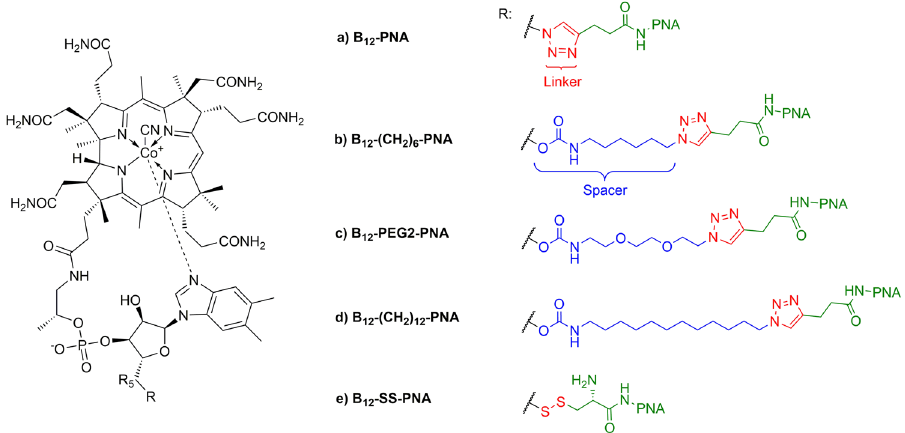
Figure 5. Structures and naming of vitamin B 12 -PNA conjugates. The carrier is at the PNA N-terminus and PNA C-terminus contains Lys.